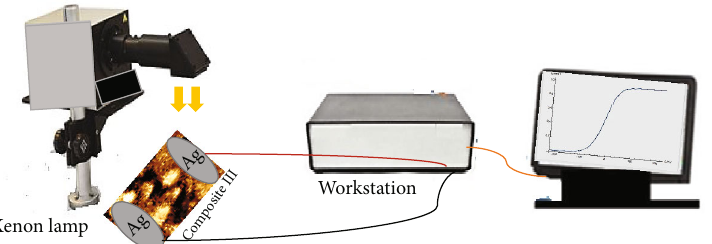
Figure 1: The schematic diagram of the electrochemical measurements for the glass/PANI/PbS photodetector using the power station under xenon lamp illumination.